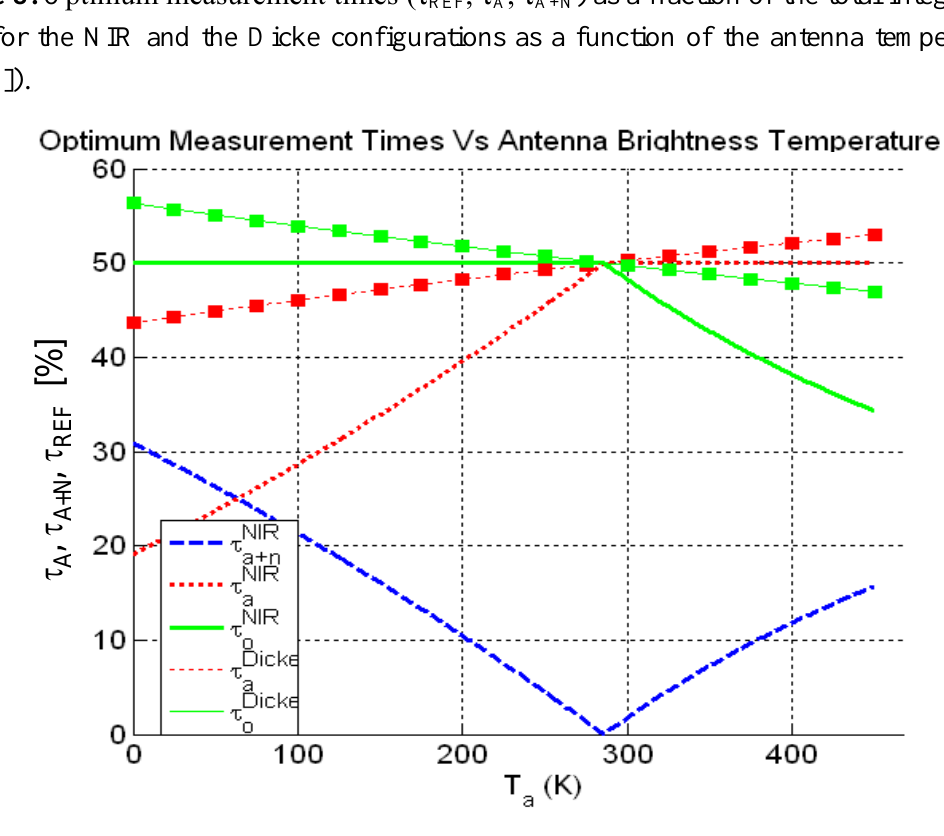
, τ , τ ) as a fraction of the total integration REF A A+N